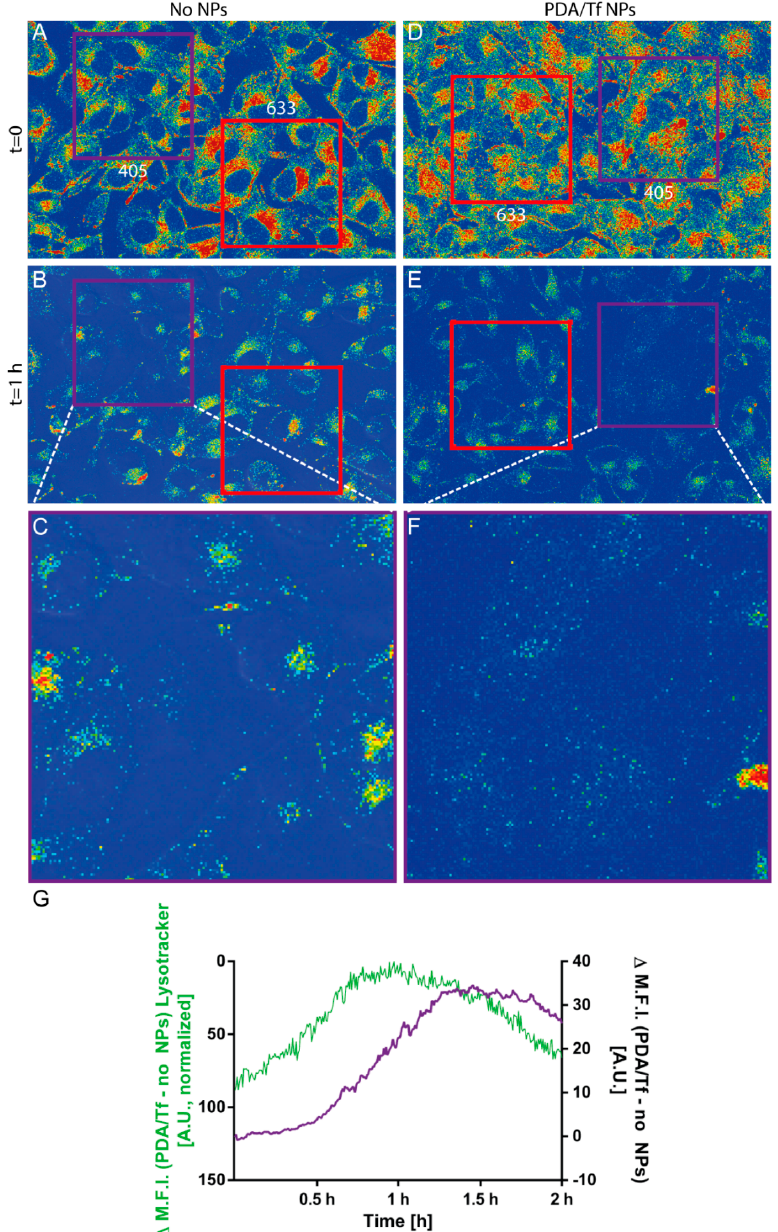
Figure 7. Visualization of the lysosomal marker in the B16F10 mouse melanoma cells exposed to no NPs ( A ) or the PDA/Tf NPs ( B ), and then irradiated with 405 nm and 633 nm light. After 1 h, less fluorescence of the lysosomal marker was observed in the cells exposed to the PDA/Tf NPs, irradiated with 405 nm light, than those exposed to the 633 nm light ( E , F, and Supplementary Video 7), as well as to the non-particle-exposed cells ( B , C and Supplementary Video 8). The decrease in the fluorescence signal of the Lysotracker ® was analyzed and plotted together with the signal corresponding to the apoptosis induction, in cells exposed to the PDA/Tf NPs, and irradiated with the UV-light ( G ). N = 3.